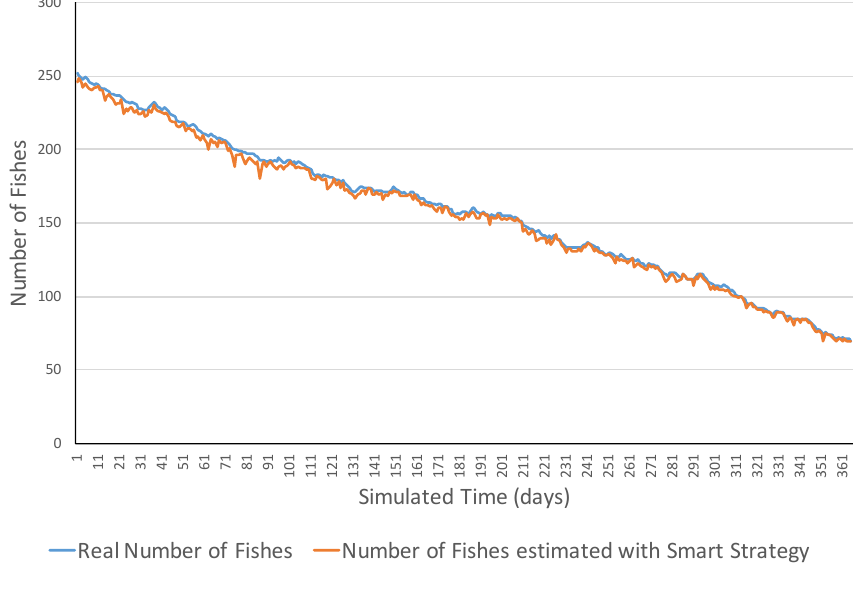
Figure 7. Simulation evolution of a decreasing ecosystem with the smart